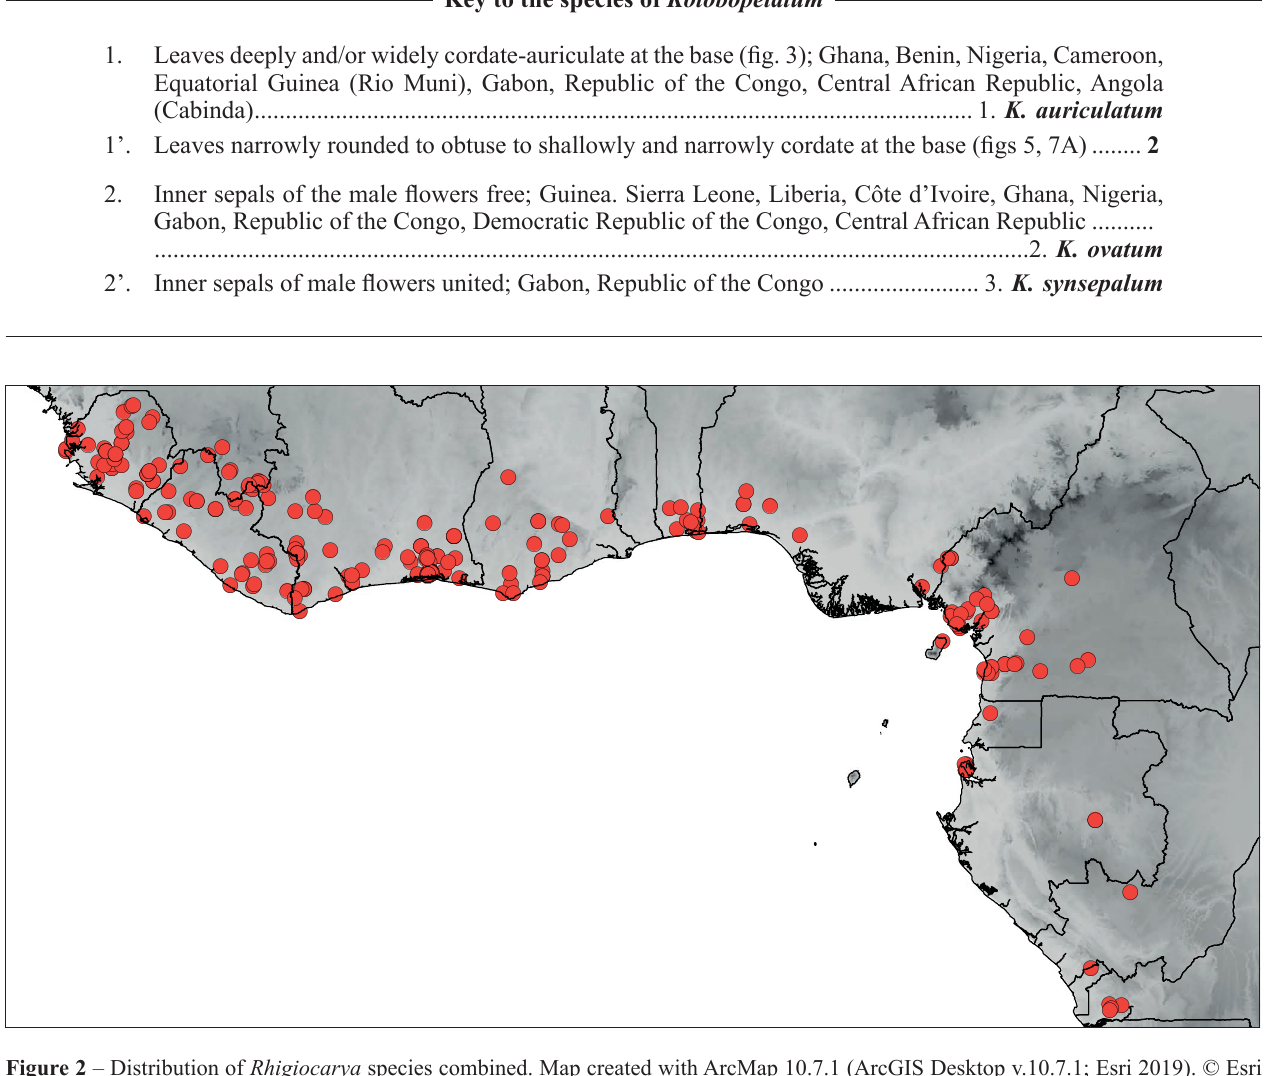
Figure 2 – Distribution of Rhigiocarya species combined. Map created with ArcMap 10.7.1 (ArcGIS Desktop v.10.7.1; Esri 2019). © Esri and its licensors, all rights